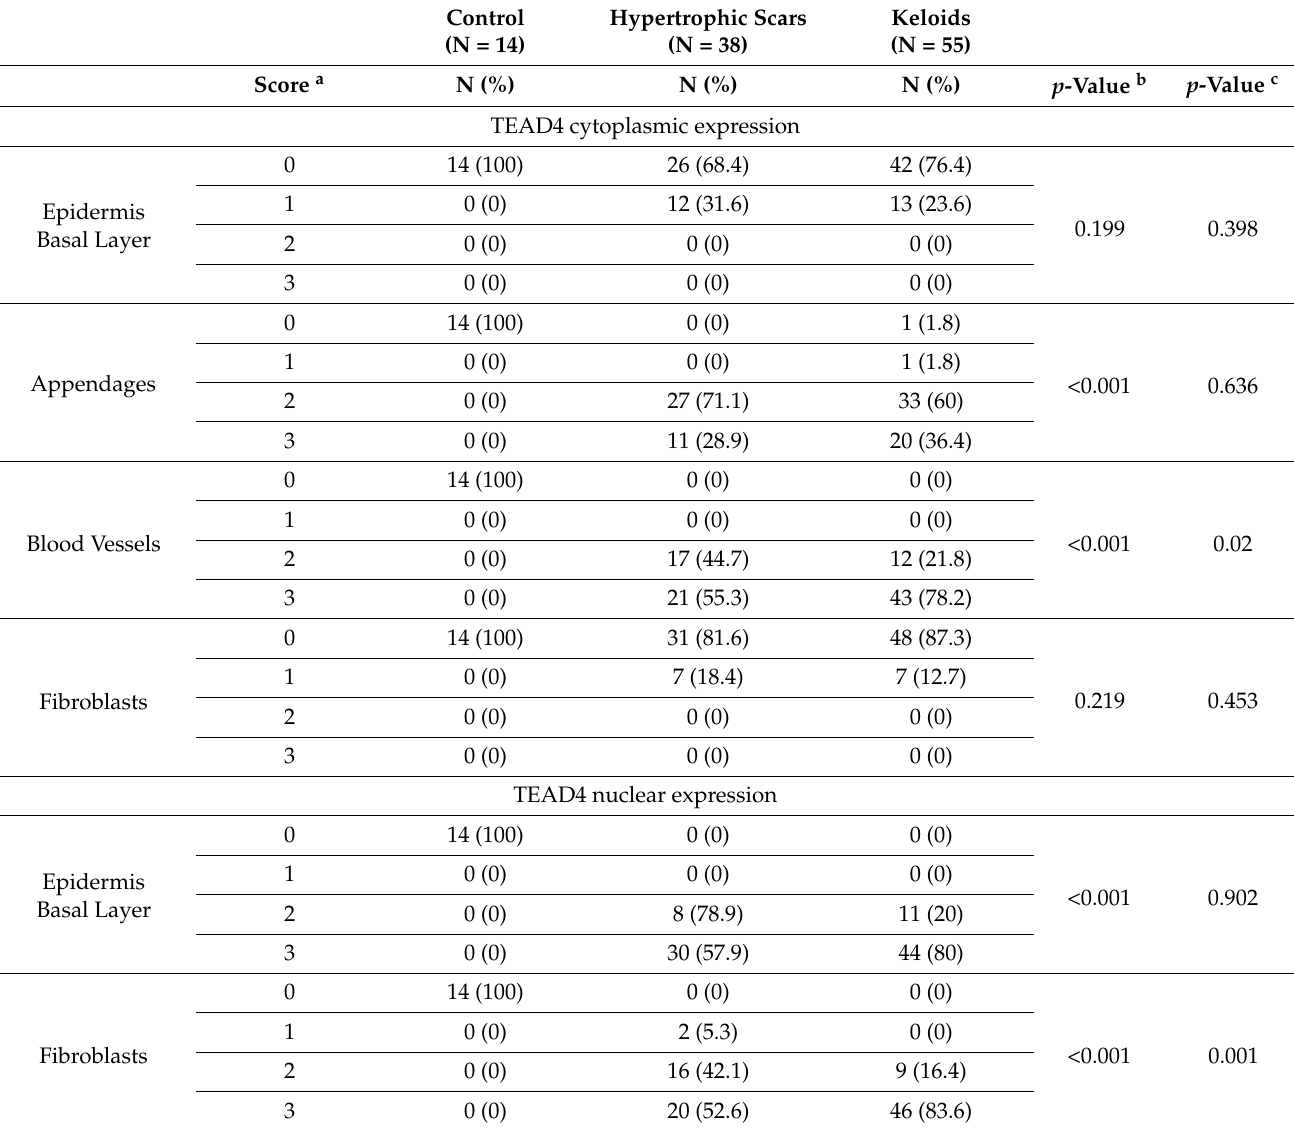
Table 4. Immunohistochemical analysis of TEAD4 expression in control skin, hypertrophic scars and